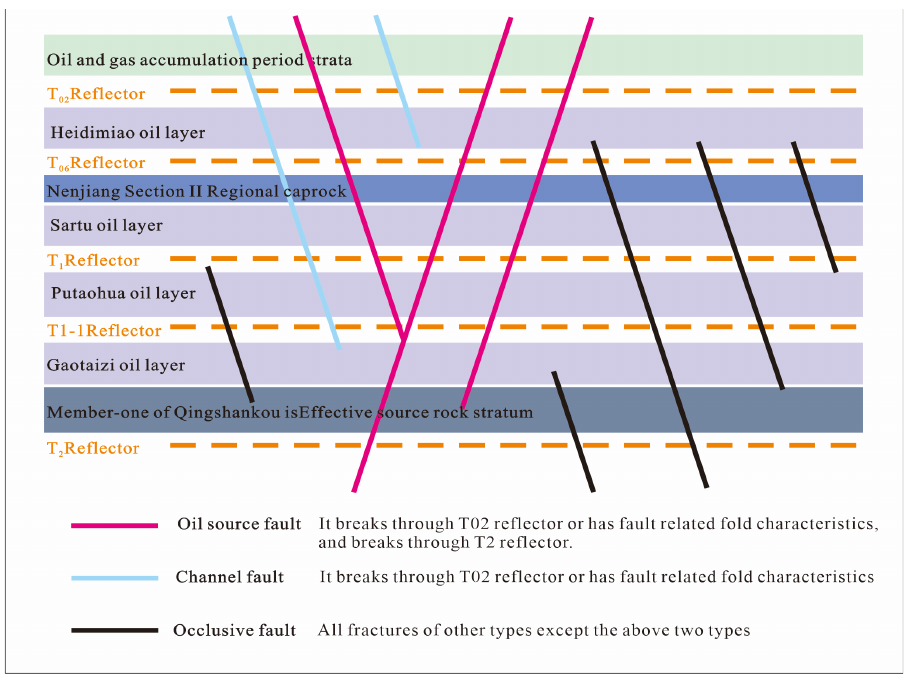
Figure 5. Fault type classification in a typical profile in the Bayan Chagan Area.